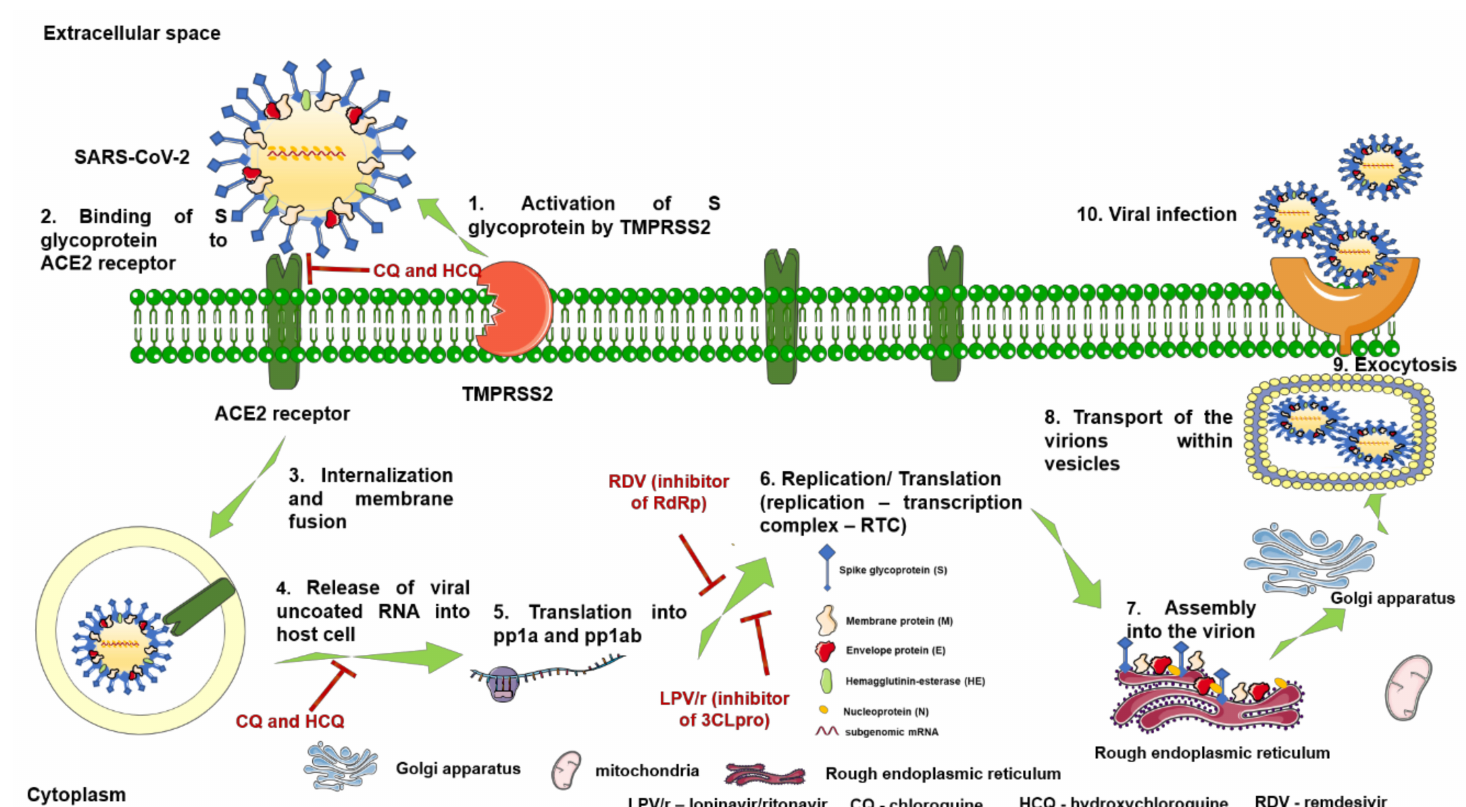
Figure 3. Mechanism of SARS-CoV-2 viral infection: (1) activation of S glycoprotein by transmembrane protease serine 2 (TMPRSS2); (2) activated S glycoprotein binds to the angiotensin-converting enzyme 2 (ACE2) receptor located on human cells surface (target for CQ—chloroquine and HCQ—hydroxychloroquine); (3) internalization and viral membrane fusion; (4) release of the uncoated RNA into the host cell (target for CQ and HCQ); (5) translation into the replicase polyproteins pp1a and pp1ab; (6) formation of replication–transcription complex (RTC) involved in replication and translation of structural proteins and synthesis of subgenomic mRNA, a process that occurs in the cytoplasm of the host cell; (7) assembly of the newly form viral RNA and the structural proteins to form the virion (in the rough endoplasmic reticulum and Golgi apparatus); (8) transport of the virions via vesicles that fuse with the plasmatic membrane; (9) release of the virus in the extracellular space via exocytosis; and (10) spread of the virus and viral infection. This image contains Servier Medical Art elements, which are licensed under a Creative Commons Attribution 3.0 Unported License; https: //